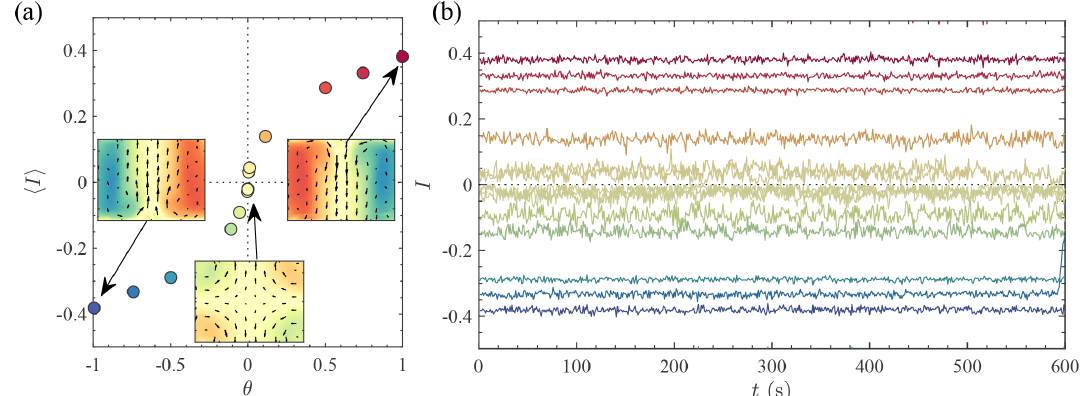
Figure 4. Seasonal cycle in the von Kármán experiment, imposed by modulating the vertical angular momentum imbalance θ . (a) Mean vertical angular momentum (cid:104) I (cid:105) response. (b) Instantaneous vertical angular momentum response for a fixed θ . The z axis is oriented upward, providing the sign of the vertical angular momentum. The curves represent instantaneous values of I . Lines are coloured according to θ , as done in (a) .